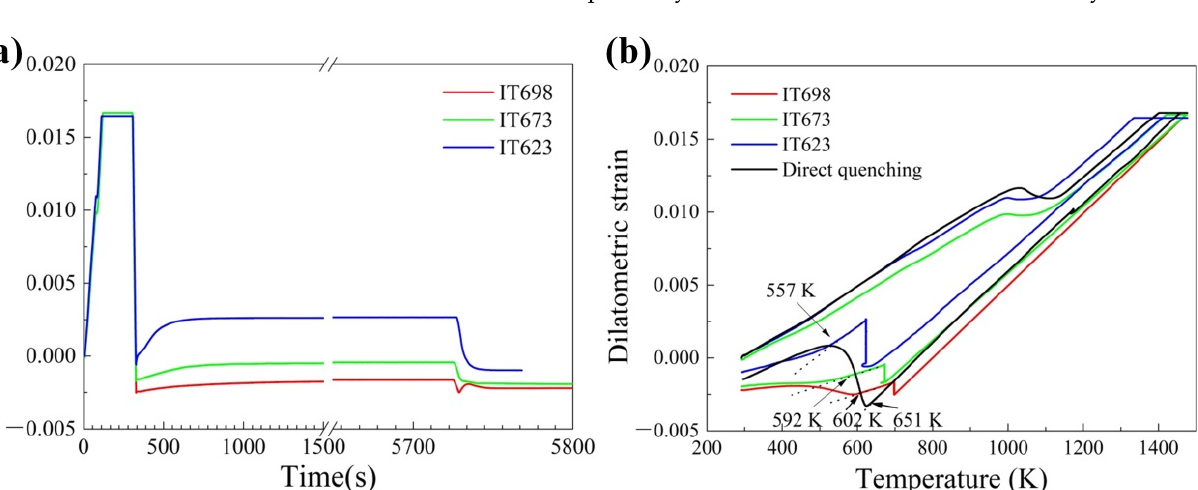
Figure 2. Colored metallography of ( a ) IT698, ( b ) IT673 and ( c ) IT623. (B: bainite, M: martensite.). The presence of a large fraction of martensite corresponds well with the dilatation curves in Figure 3. The dilatation starts at the beginning of isothermal holding and lev- els off before the end of isothermal holding (see Figure 1a), reflecting the whole bainite transformation process. Retained austenite finally transforms into martensite during the gas-quenching. From Figure 3b, the bainite fraction is measured by lever rule [23,24] and the M s temperature for IT698, IT673 and IT623 are determined to be 42% and 602 K, 53% and 592 K, 72% and 557 K, respectively. Retained austenite is not detected by EBSD.